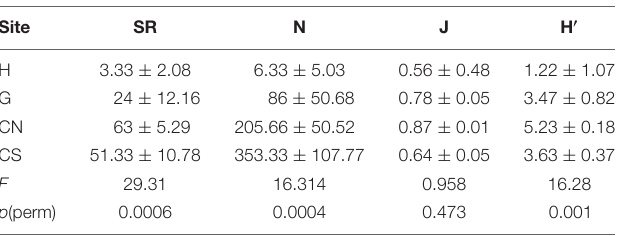
TABLE 4 | Macrofauna